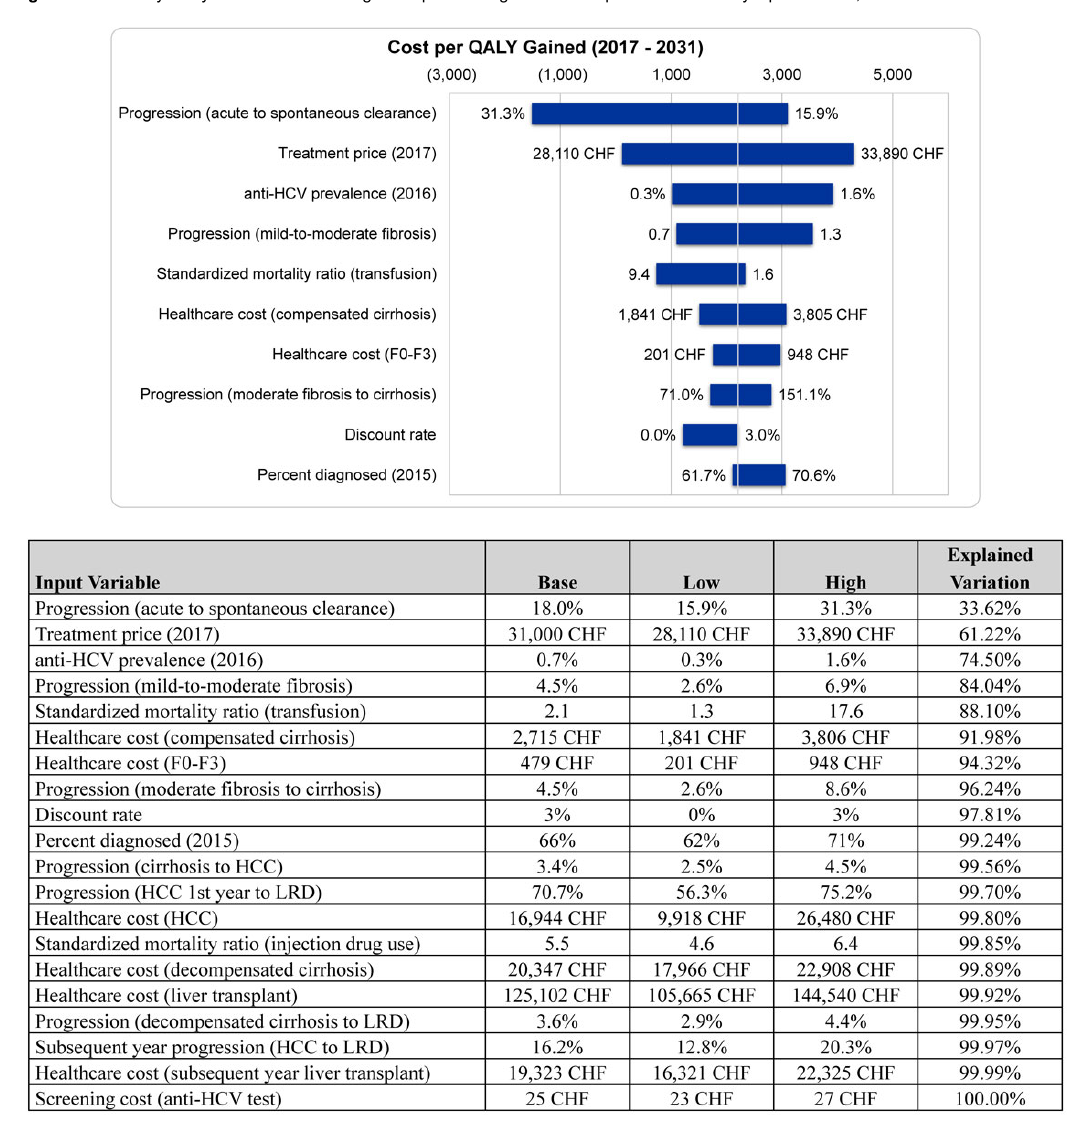
Figure 2: Sensitivity analysis around the average cost per QALY gained and explained variation by input variable,